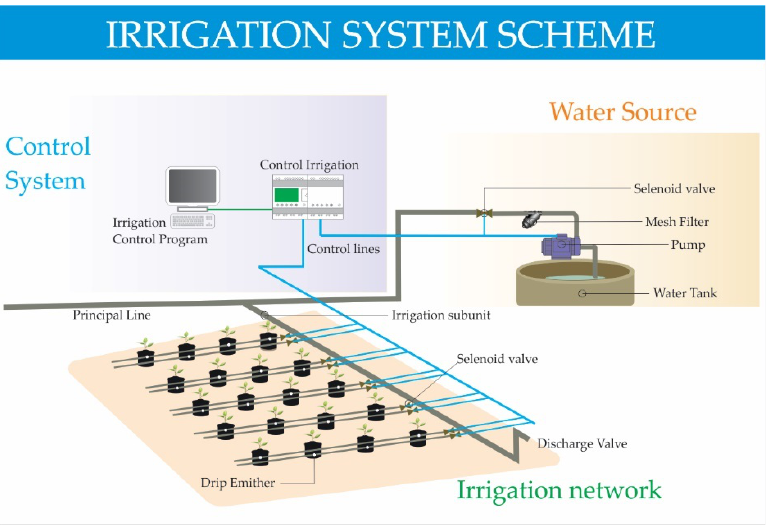
Figure 2. Irrigation control system used for each drought-stress condition evaluated. The scheme represents one of the experimental plots.